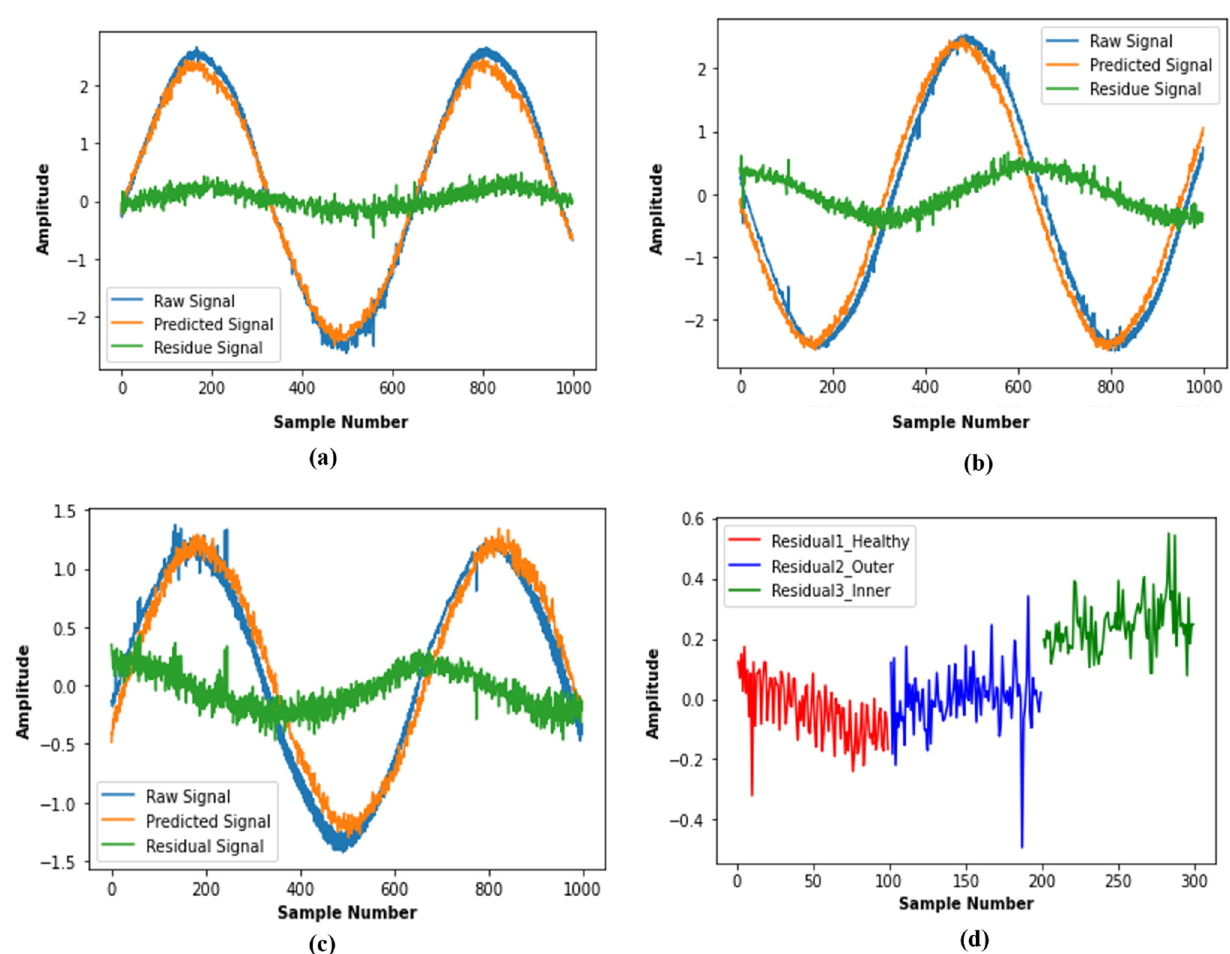
Figure 8. The raw, predicted, and residual signal of bearings corresponding to ( a ) normal, ( b ) outer race fault, ( c ) inner race fault conditions, and ( d ) residual values for 100 samples of three different conditions.